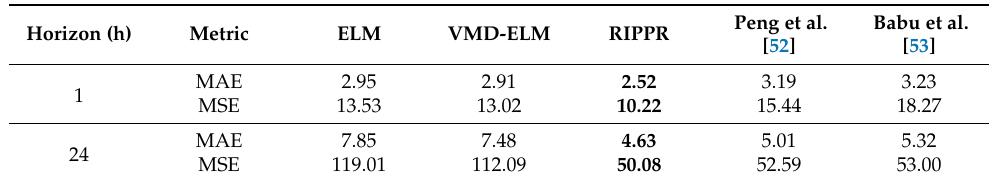
Table 5. Results comparison for dataset E.